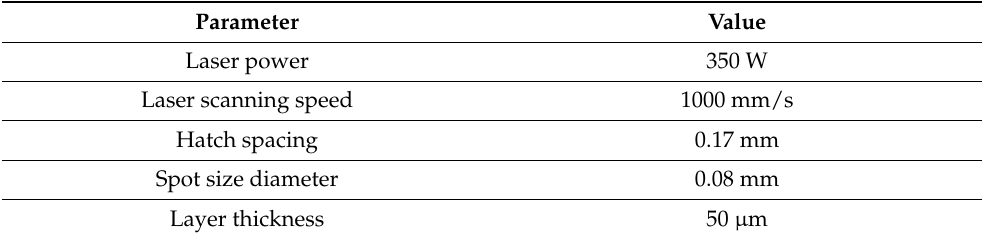
Table 1. Overview of SLM500 process parameters for the production of cylindrical